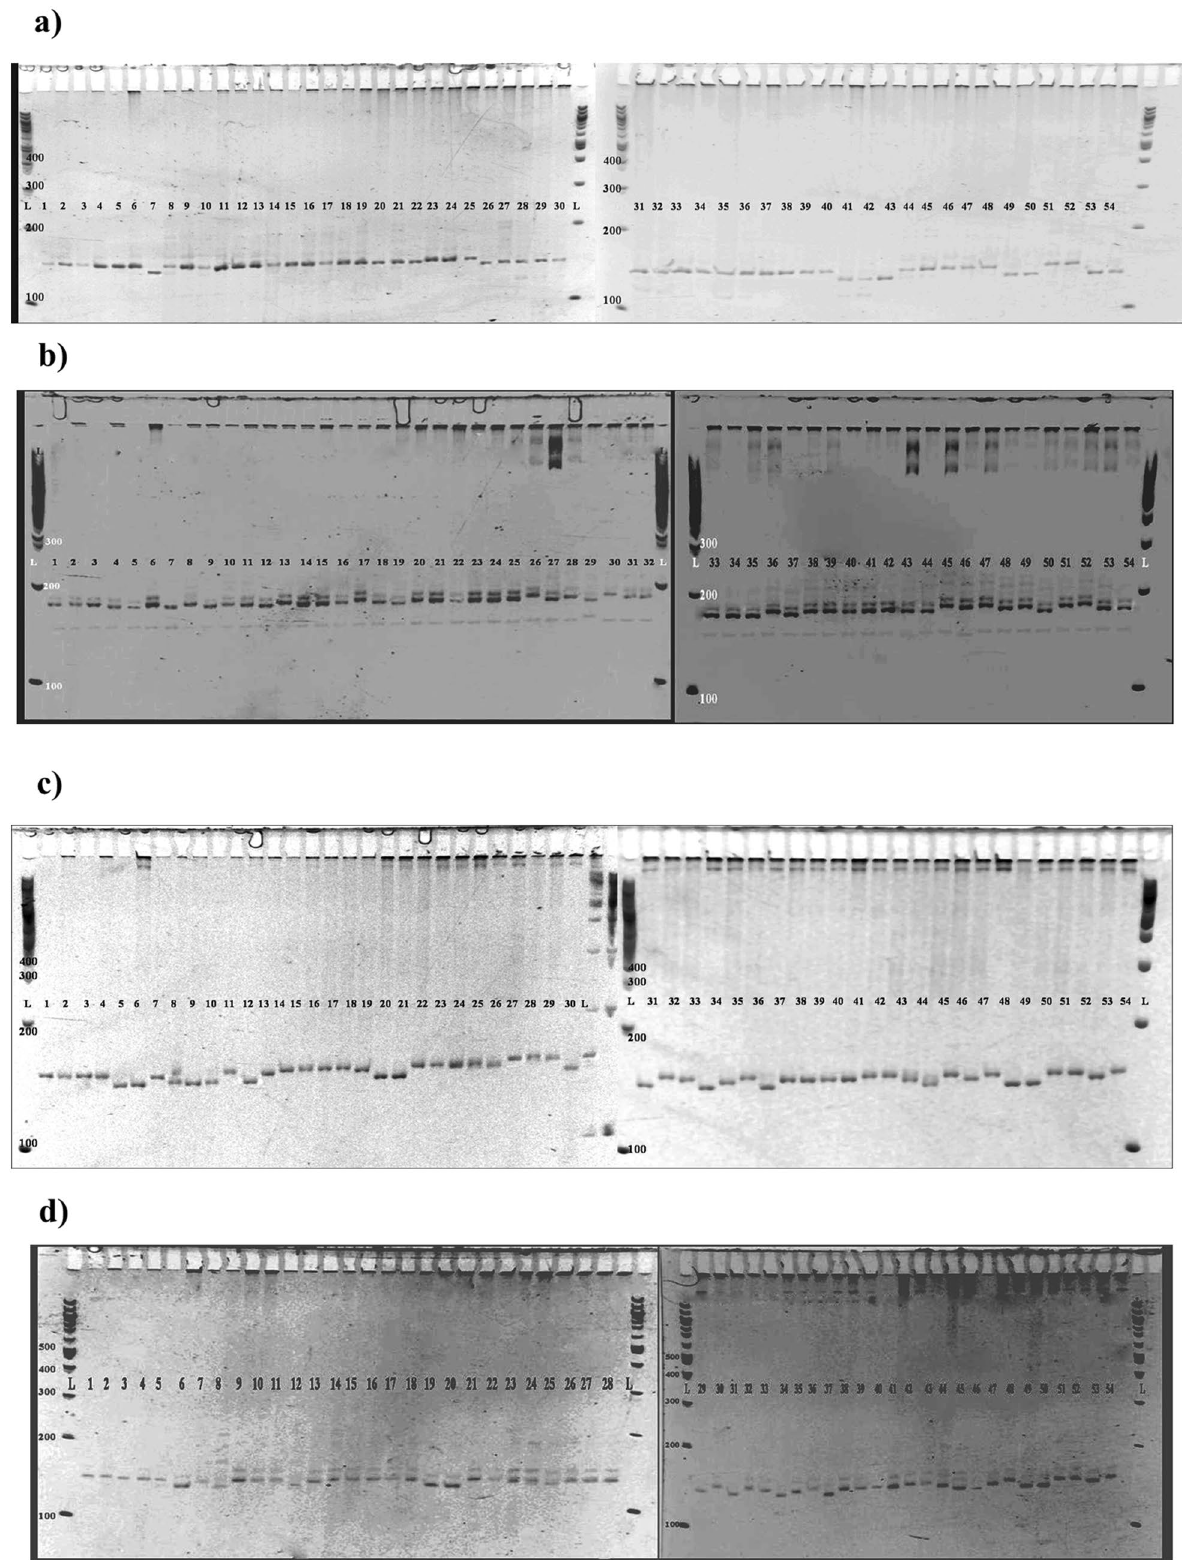
Figure 8. Amplification of genomic DNA from different wheat genotypes with ( A ) Tacg-SSR11, ( B ) TamiR- 160a, ( C ) TamiR-169k and ( D ) TamiR-169l. L represents 100 bp